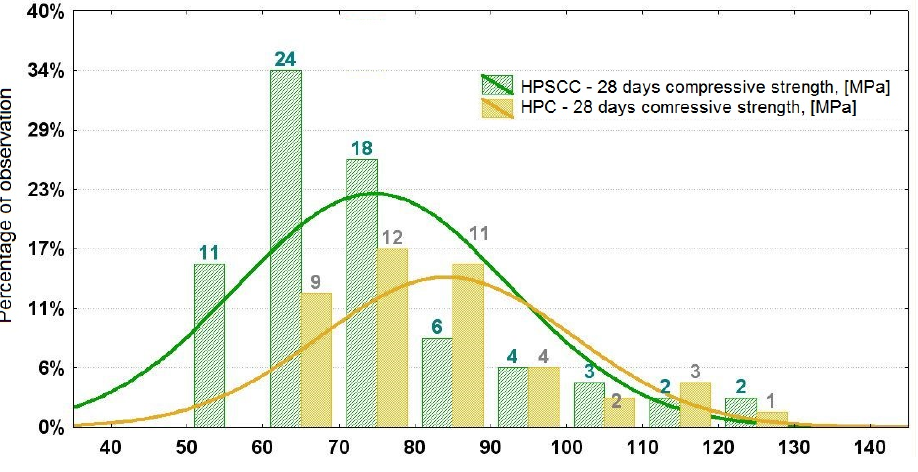
Figure 1. Histogram of 28-day compressive strength for HPSCC and HPC [18,21–54]. Table 1. Analysis of variance of factor tests of the impact of HPSCC composition on 28-day compressive strength [18,21–54].